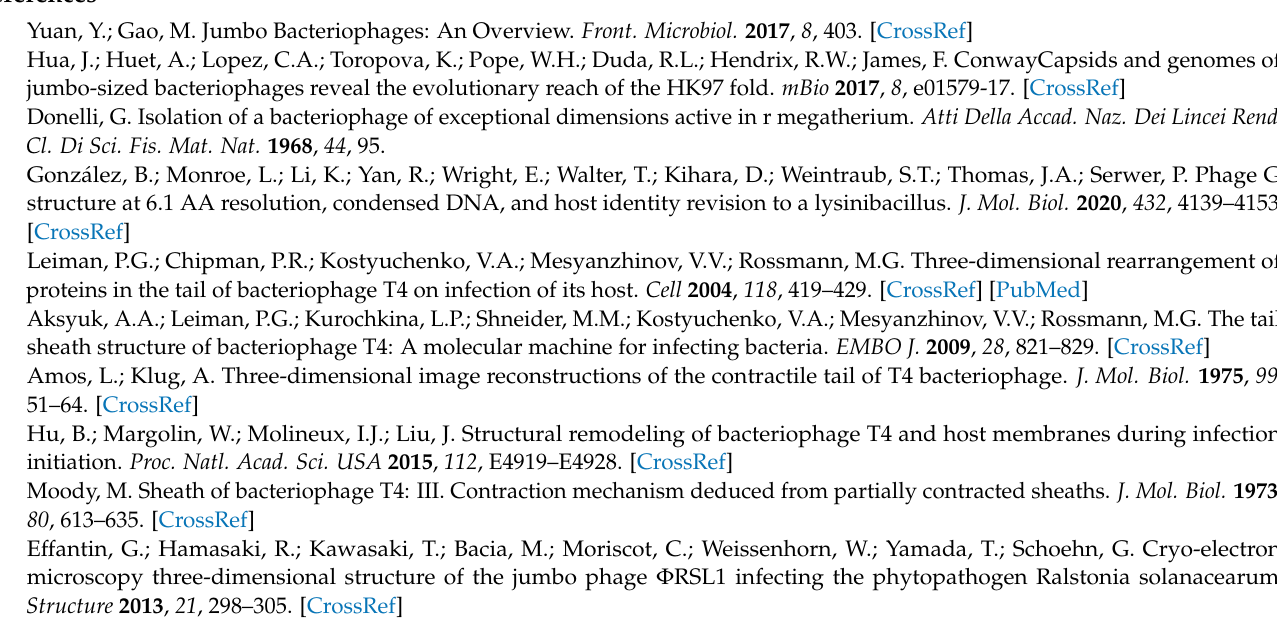
Table S1: Data collection parameters of phage G cryo-EM dataset, Table S2: Image processing details of the phage G helical tail sheath